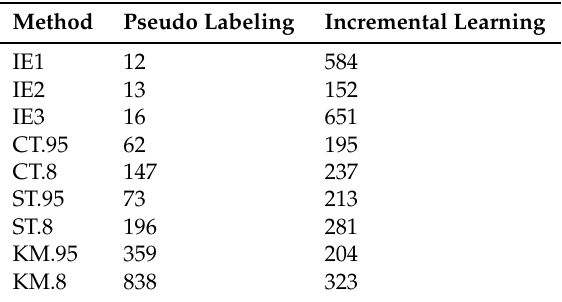
Table 4. Time cost (in